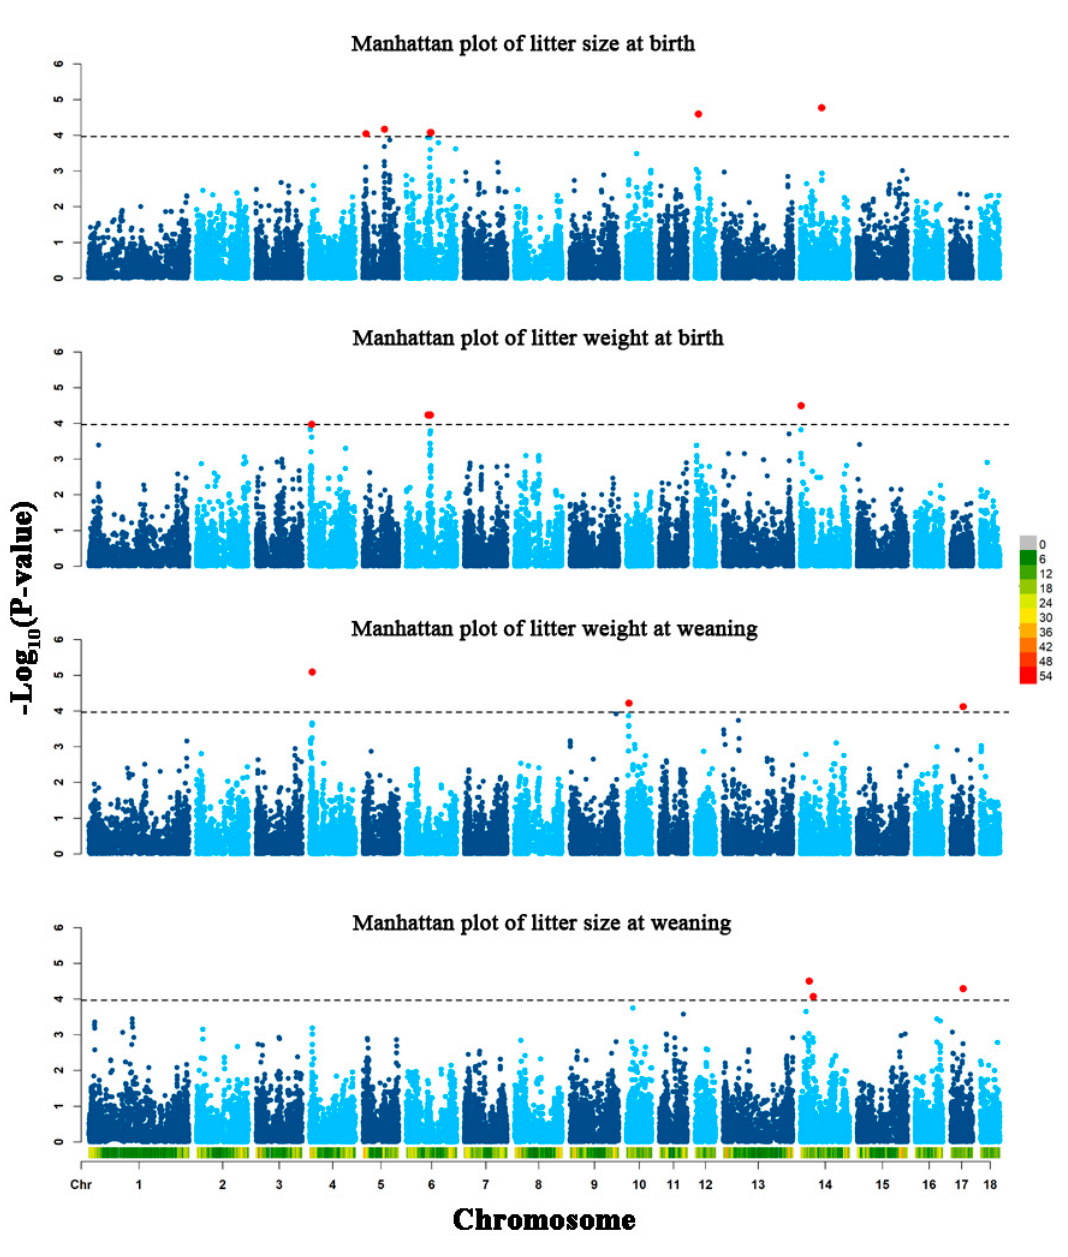
Figure 1. The Manhattan plots of four porcine reproductive traits distinguished by text labels. The y-axis of the Manhattan plots display the -log10 ( p -value) of each SNP in the genome-wide association analysis. The black horizontal lines divide SNP with p -values < 1.08e–4. The red dots stand for the potential SNPs associated with the traits of LSB, LWB, LSW, and LWW.